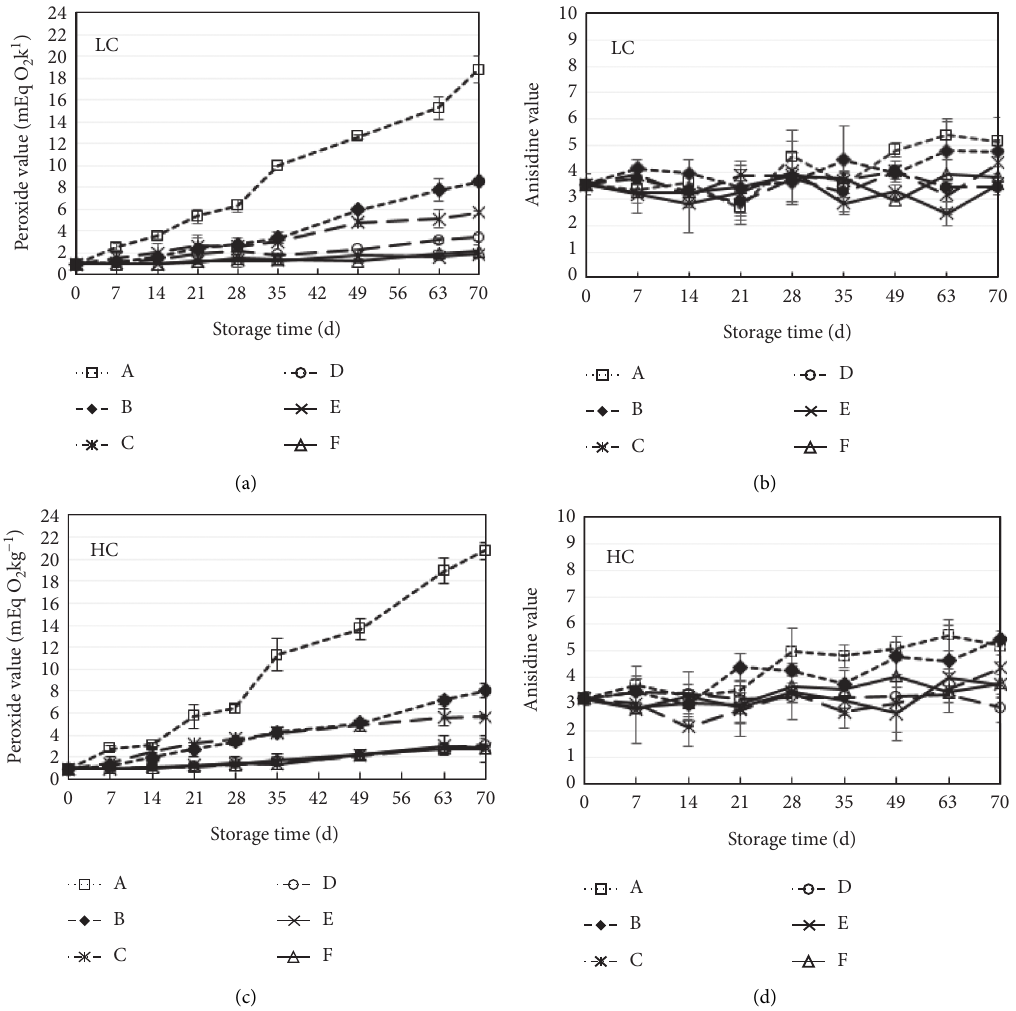
Figure 2: Evolution of peroxide and p-anisidine values of fortified oils during storage. A: samples stored in transparent bottles at room temperature with filling level of 50%; B: samples stored in transparent bottles at room temperature with filling level of 100%; C: samples stored in dark-brown bottles at room temperature with filling level of 50%; D: samples stored in dark-brown bottles at room temperature with filling level of 100%; E: samples stored in dark-brown bottles at 4 ° C with filling level of 50%; F: samples stored in dark-brown bottles at 4 ° C with filling level of